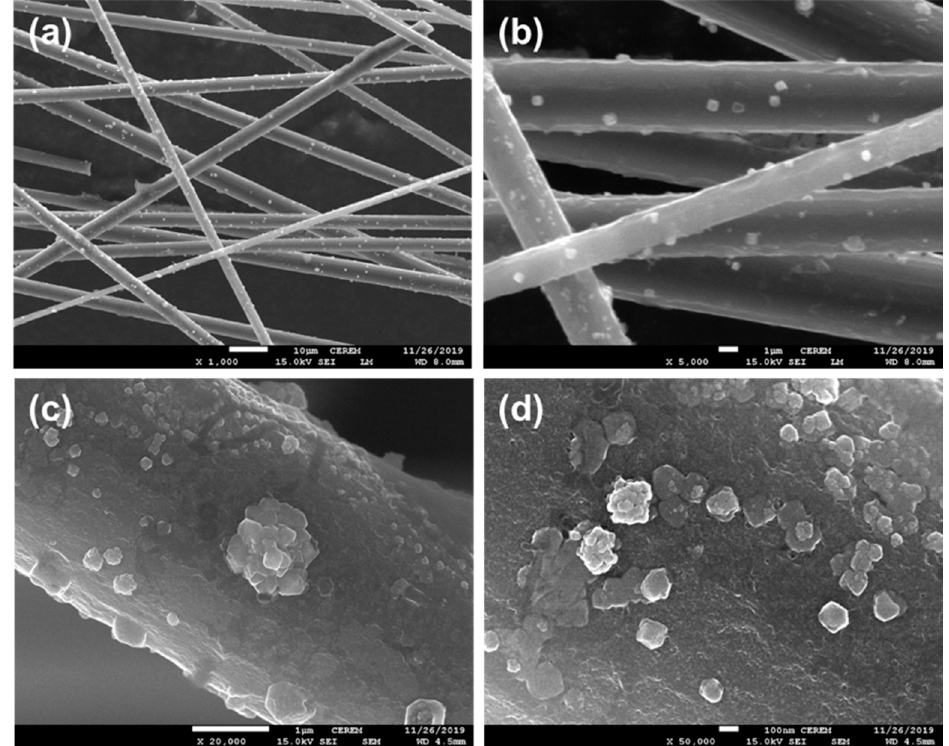
Figure 9. SEM images with different magnifications of the carbon long fibers copper-coated using the electroplating copper coated method upon passing 8 μ A current in the electroplating cell for 1 min. ( a – d ) Low to high resolutions.